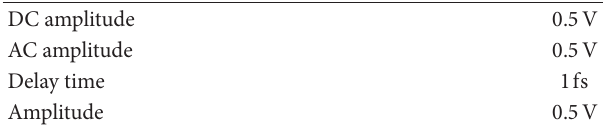
Table 1: Sine input